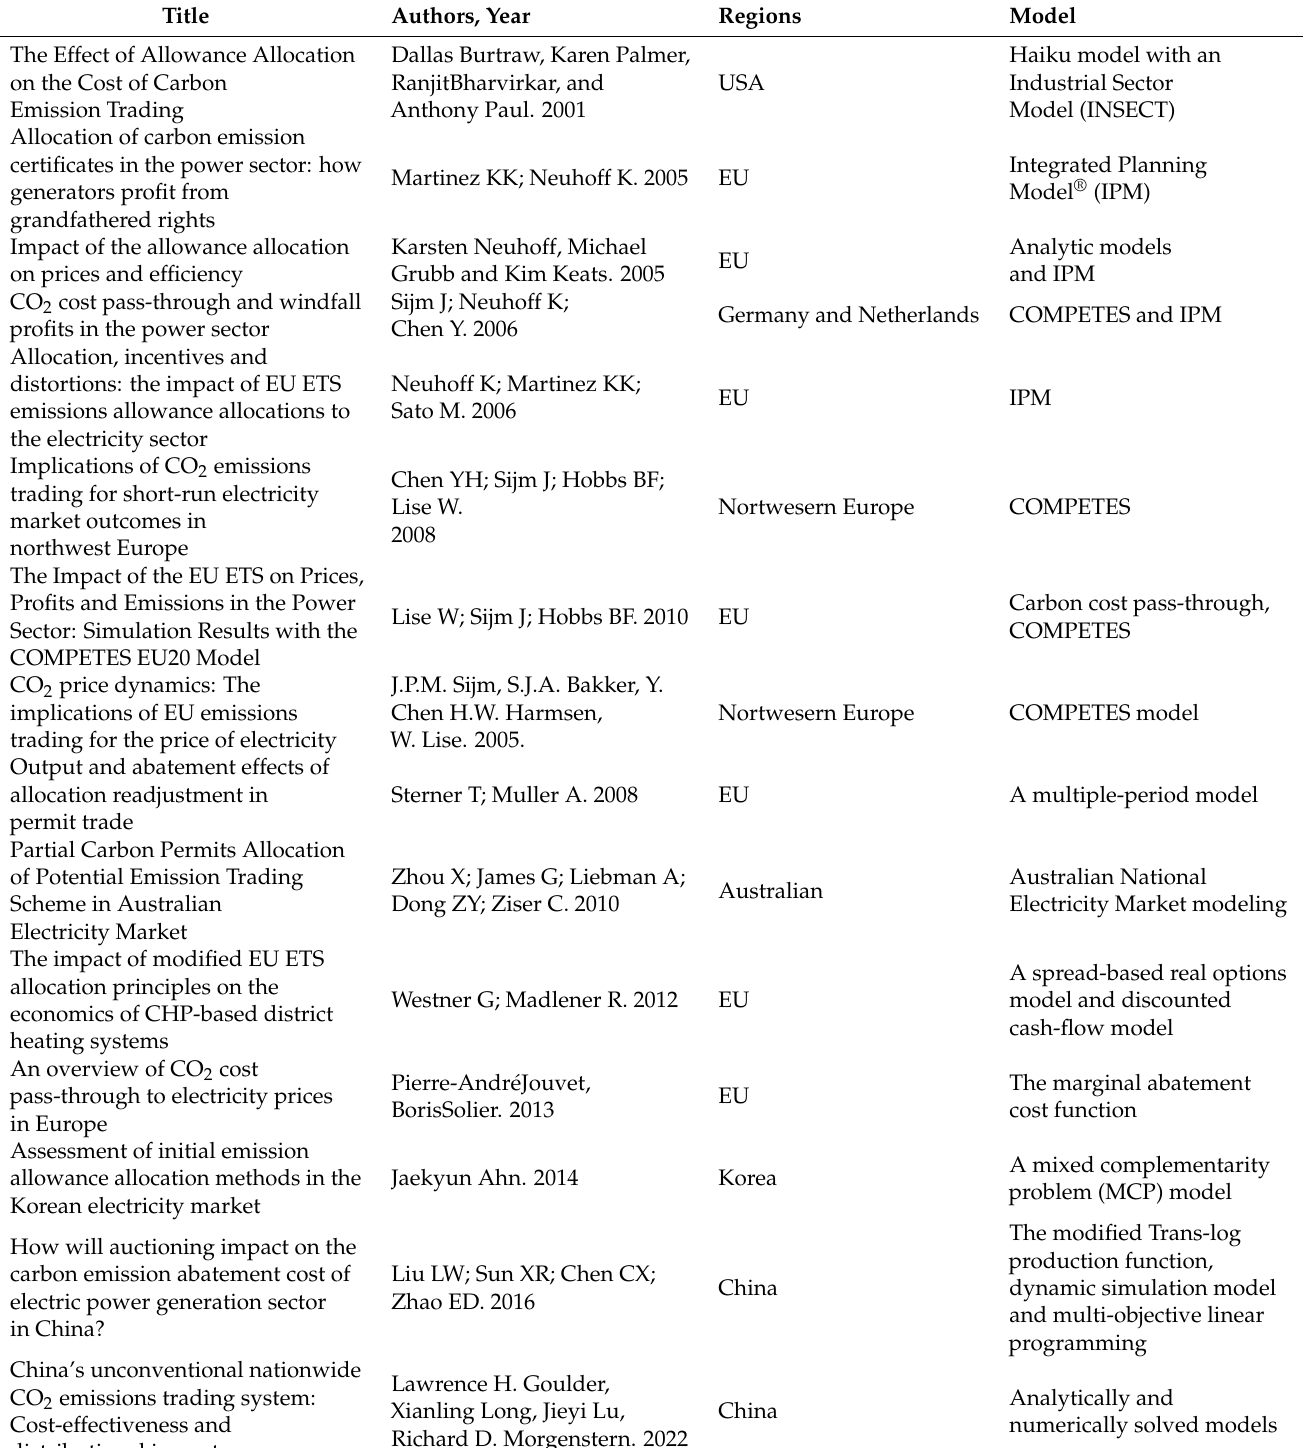
Table 6. Microscopical research on the impact of allowance allocation in the power industry